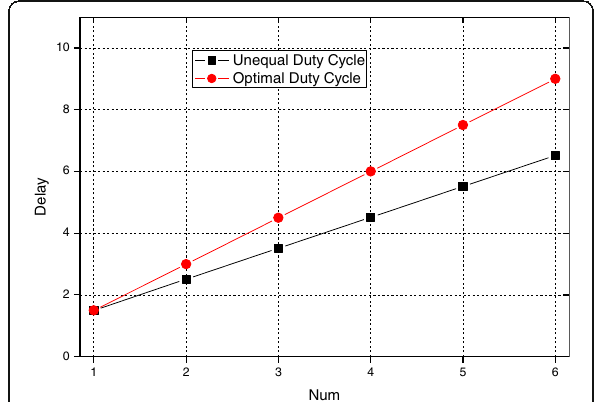
Fig. 14 The delay from each node in linear network to sink (MQAM)